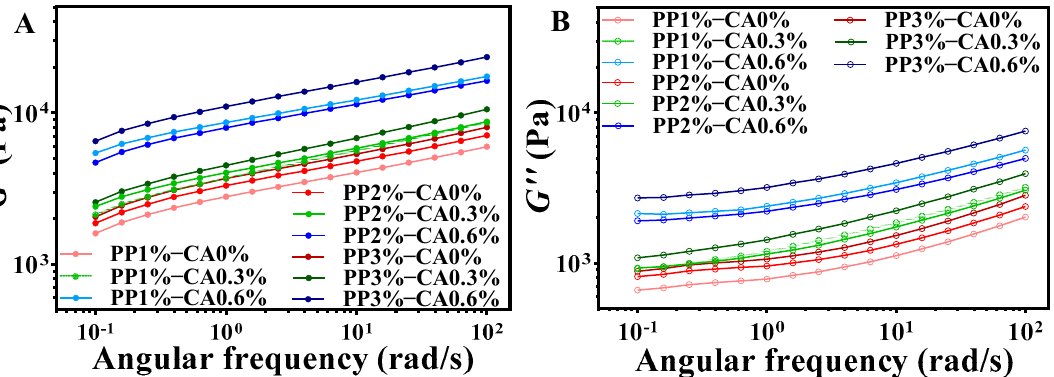
Figure 4. Frequency curves of restructured mackerel mince with different PP concentration and CA addition: ( A ) is the stored modulus ( G ′ ) of restructured mackerel mince; ( B ) is the loss modulus ( G ″ ) of restructured mackerel mince.